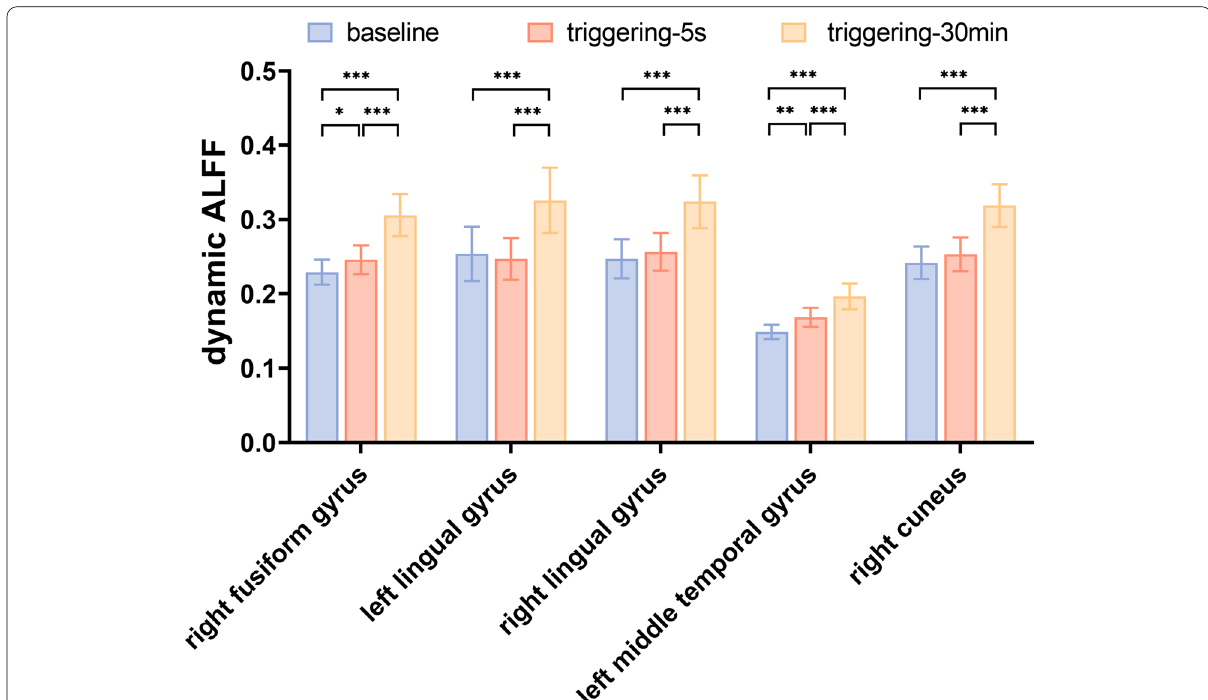
Fig. 5 Post hoc comparisons of analysis of variance. The connection between two bars represents significant between-time differences of dALFF (*represents significant level P < 0.05, **denotes significant level P < 0.01, and ***indicates significant level P < 0.001, Bonferroni correction). ALFF, Amplitude of low-frequency fluctuation; dALFF, dynamic amplitude of low-frequency fluctuation; baseline, the rs-fMRI was performed before stimulating the trigger zone; triggering-5s, the rs-fMRI was performed within 5s after stimulating the trigger zone; triggering-30min, the rs-fMRI was performed in the 30th minute after stimulating the trigger zone